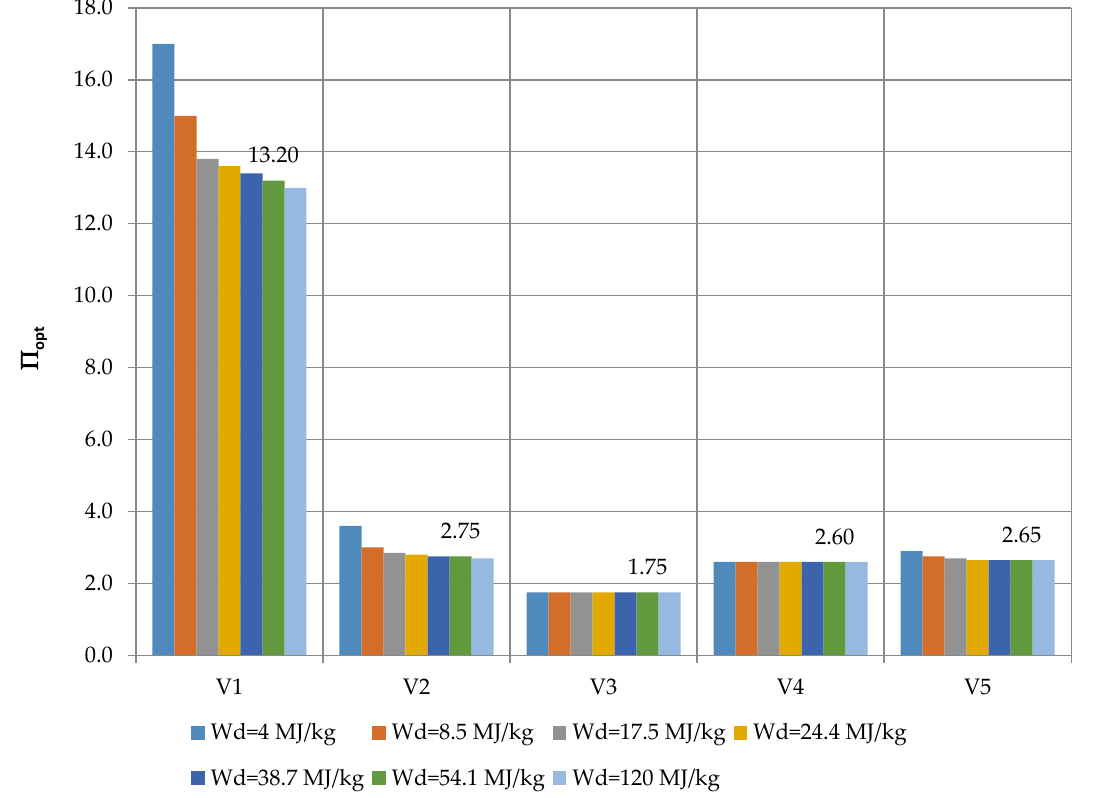
Figure 2. The effect of a compression on the value of the efficiency referred to the maximum value of variant 1 for two exemplary fuels.